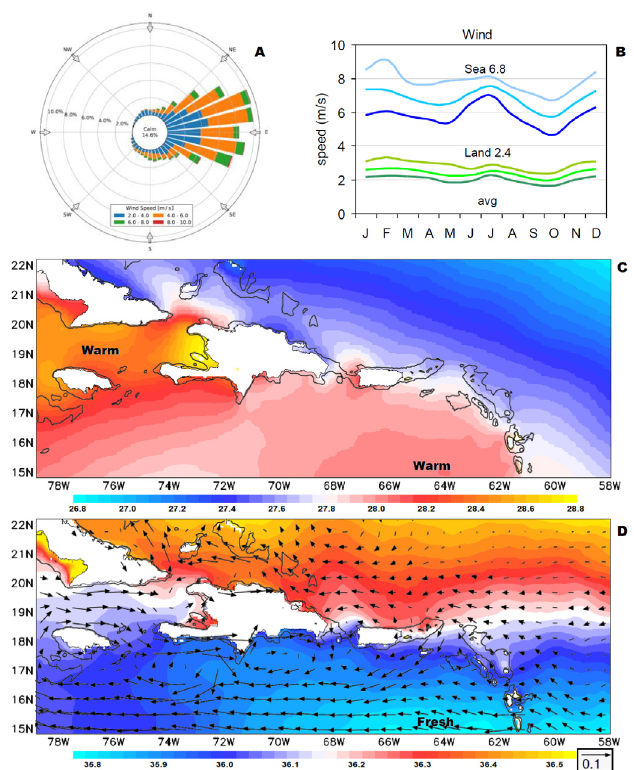
Figure 2. ( a ) Observed wind rose frequency distribution on the east coast of Puerto Rico. ( b ) Caribbean mean annual cycle and deciles of ECMWF5 surface wind speed over sea and land. HYCOM climatology of: ( c ) SST (°C) and, ( d ) surface salinity (ppt) and currents (vector); including 500 m depth contour.